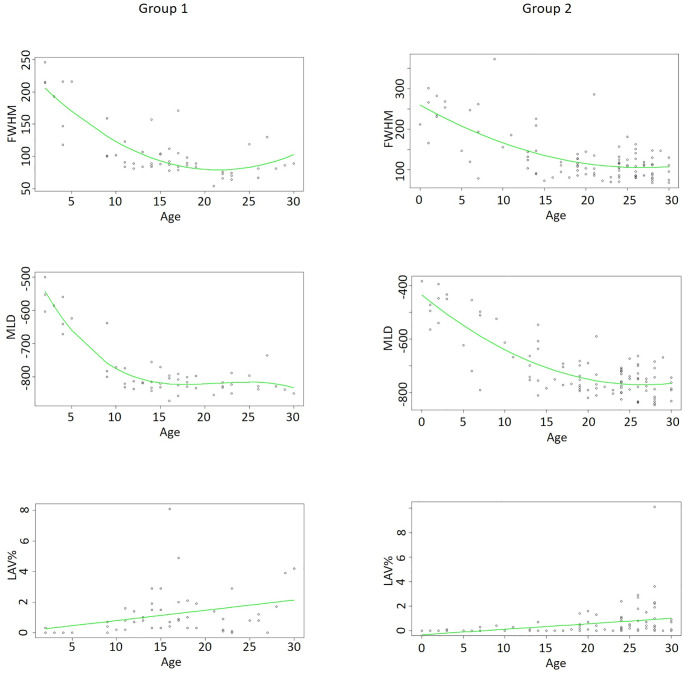
Regression models.Shown are the regression models for quantitative CT parameters—left row for group 1, right row group 2. For MLD and FWHM polynomial regression was used. In LAV linear regression models. For MLD a R-squared of 0.85 (group 1) and 0.67 (group 2) were calculated. For FWHM R-squared was 0.68 (group 1) and 0.48 (group 2), respectively. For LAV R-squared of 0.1 (both groups) were calculated.